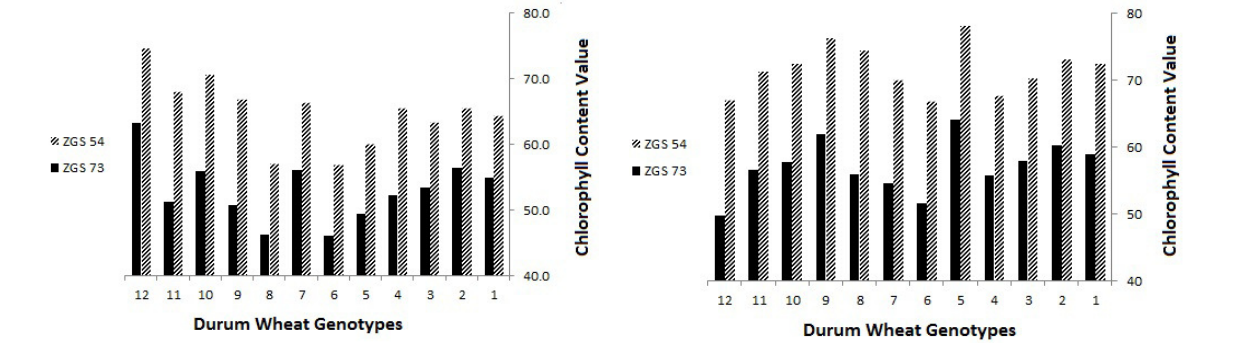
Fig. 6. Canopy temperature depression values of durum wheat genotypes in supplementary irrigation